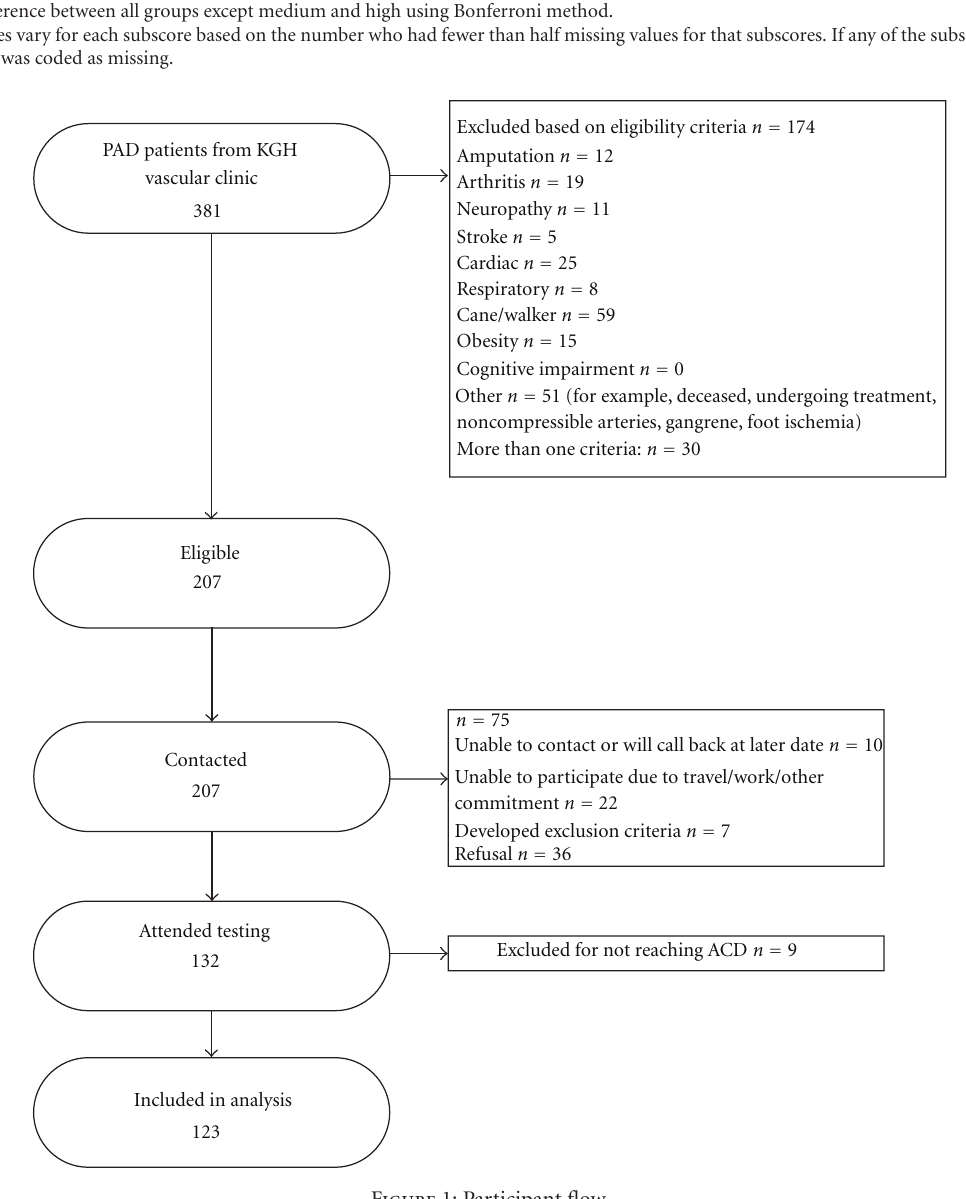
Figure 1: Participant